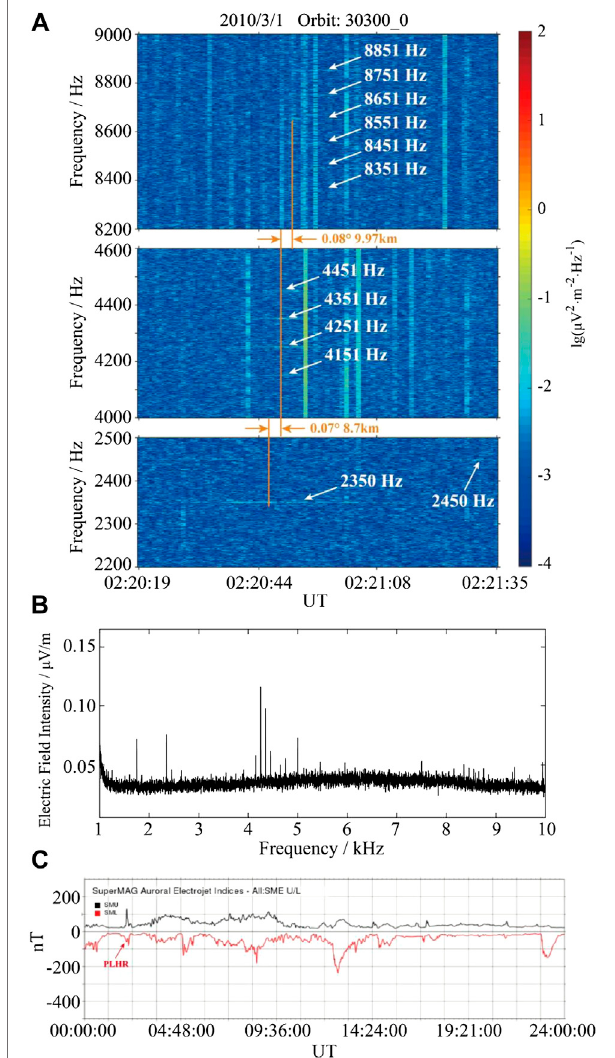
FIGURE4| UncommonPLHRoccurrencesoverthe500 kVShunyiAC- to-AC substation. (A) Time-frequency spectrogram of the electric fi eld intensity along orbit 30,300_0. (B) Amplitude-frequency characteristics of the electric fi eld intensity. (C) Fluctuation of the geomagnetic indices